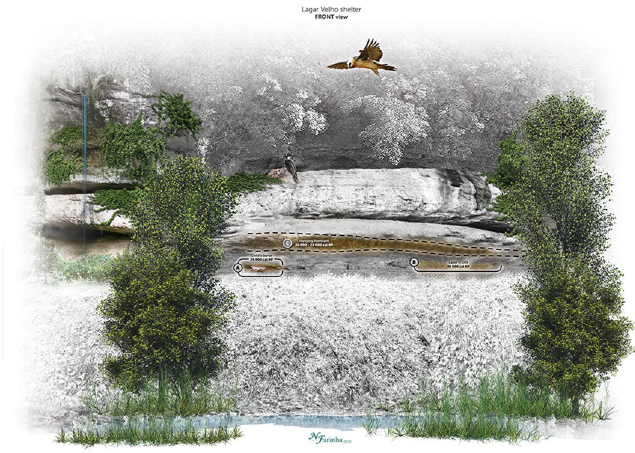
Figure 9. Illustration of Lagar Velho rock shelter viewed from north recreating a bearded vulture couple nesting in a recess above the occupation area, 29 ka cal BP. ( A) —location of the infant burial; ( B )—layer 143 from where the studied coprolites were recovered; ( C )—the Hanging Remnant, a recess preserving sediments with Upper Palaeolithic remains dated from 26 to 24 ka cal BP 26 . Nuno Farinha (adapted from a previous version published in Leiria Museum